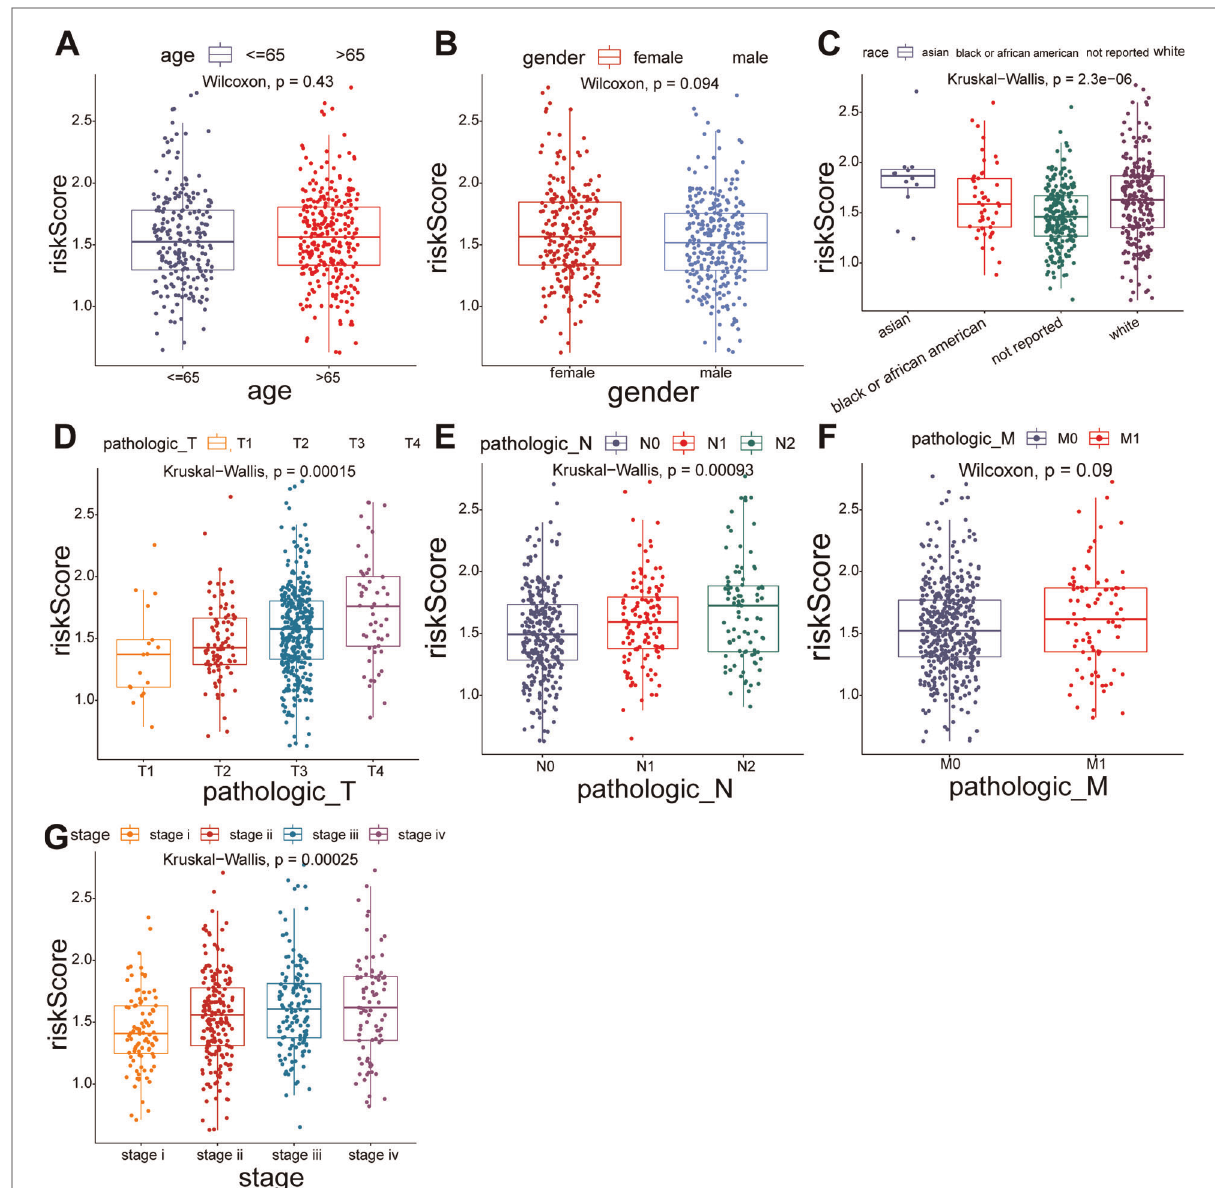
FIGURE 3 Comparison of risk scores for different subgroups of clinical parameters. ( A ) Age>65 vs. Age ≤ 65. ( B ) Female vs. Male. ( C ) Asian vs. Black vs. White. ( D ) T1 vs. T2 vs. T3 vs. T4. ( E ) N0 vs. N1 vs. N2. ( F ) M0 vs. M1. ( G ) Stage I vs. II vs. III vs.